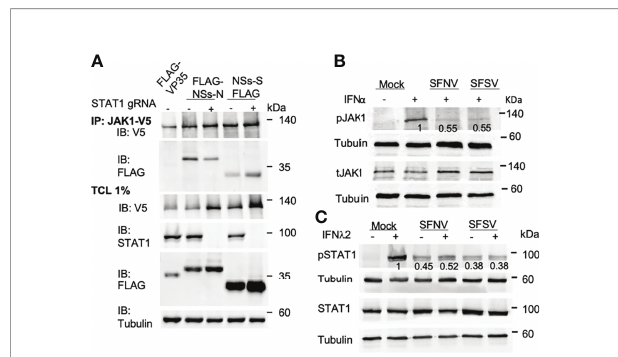
FIGURE 5 | NSs interact with Jak1 independently and inhibits its phosphorylation. (A) HEK293 cells expressing NT sgRNA or sgRNA for STAT1 were cotransfected with plasmids expressing V5-Jak1 and FLAG- tagged NSs. IP was performed 24 h post-transfection using an anti-V5 antibody. Total cell lysates (TCL) and IP products were analyzed by western blot using the indicated antibodies. (B) SFNV and SFSV infection inhibits Jak1 phosphorylation. A549 cells were infected with SFNV or SFSV. The next day the cells were treated with IFN a (1000 U\ml) for 30 mins. Western blot analysis was performed as described above using Jak1 and phospho-Jak1 speci fi c antibodies. Tubulin was used as a loading control. Numbers below the bands represent average bands intensity from three independent experiments quanti fi ed using ImageJ and are expressed as a percent of mock-infected and stimulated control. (C) SFNV and SFSV infection inhibits IFN l 2 signaling. A549 cells were infected with SFNV or SFSV. The next day the cells were stimulated with IFN l 2 (70 ng\ml) for 20 mins. Western blot analysis was performed using total STAT1 and phospho- STAT1speci fi c antibodies. Tubulin was used as a loading control.